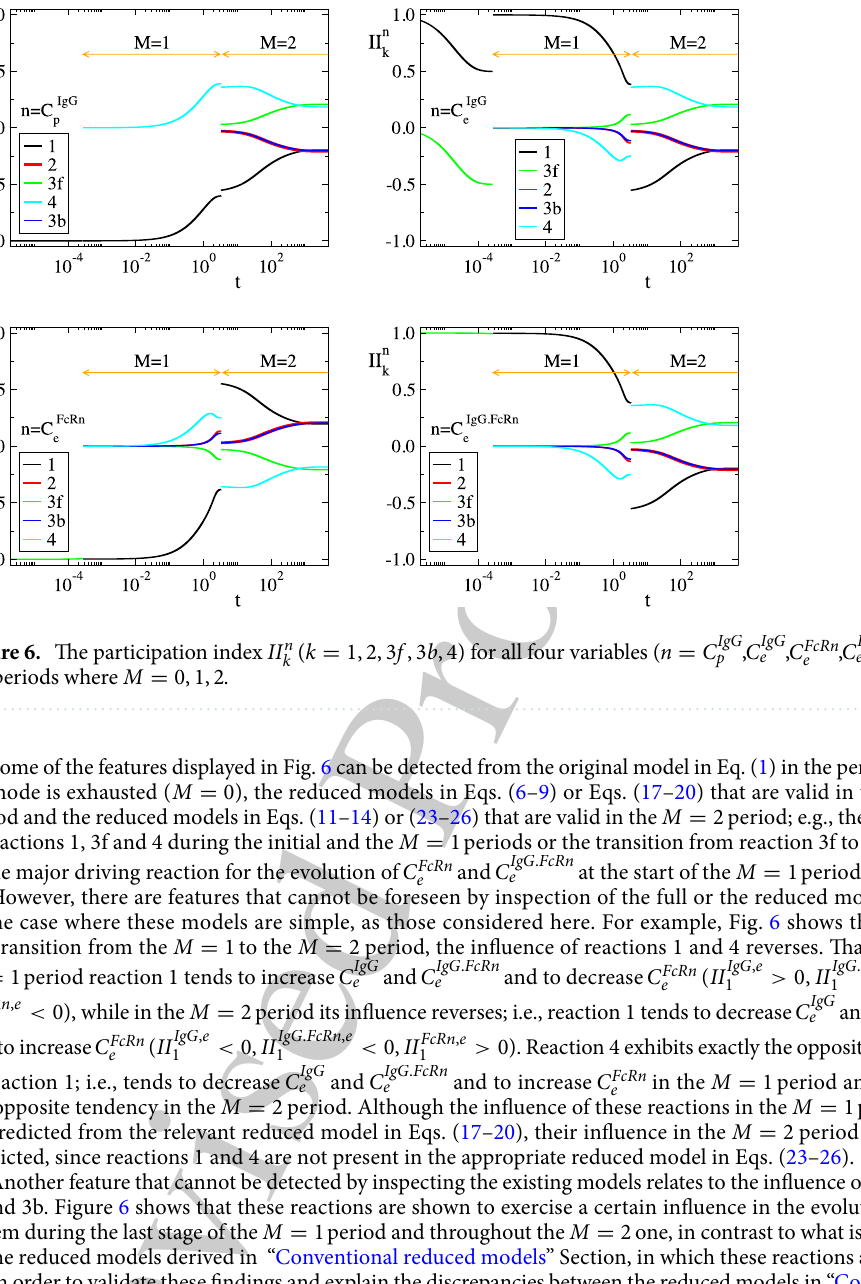
Figure 6. The participation index II n k ( k = 1, 2, 3 f , 3 b , 4 ) for all four variables ( n = C the periods where M = 0, 1, 2